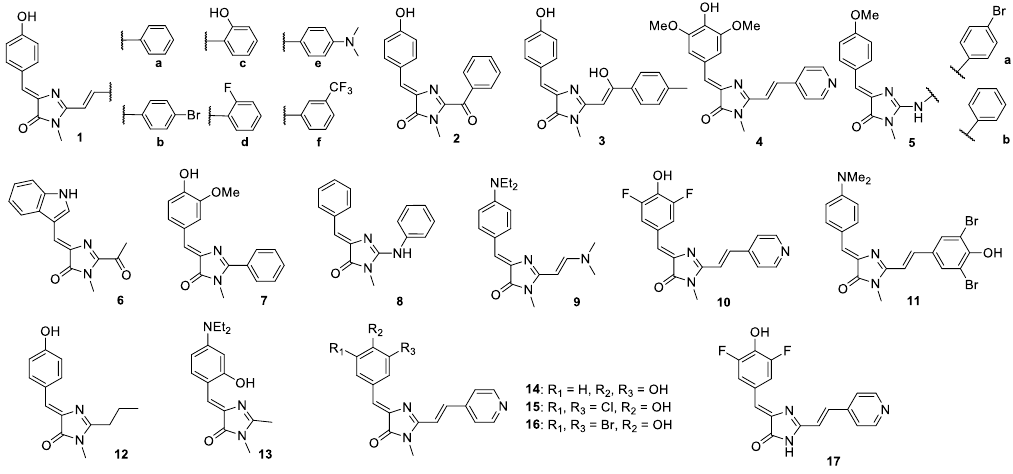
Figure 3. Structures of GFP fluorophore analogues used in the study.